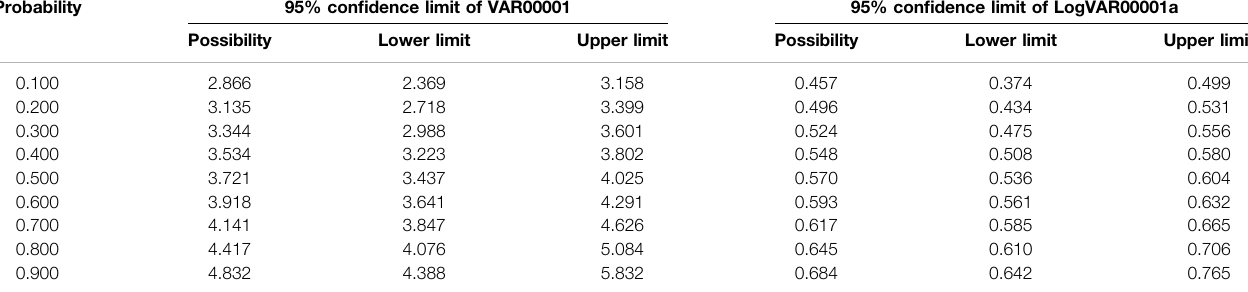
TABLE 2 | Probability and con fi dence limit of semicarbazide in A. japonicas . Probability